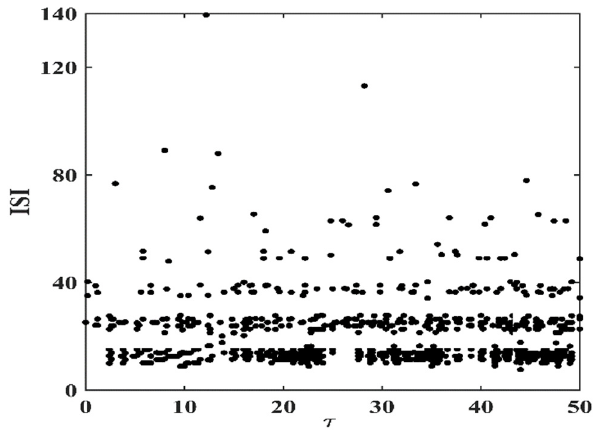
τ ; other parameters